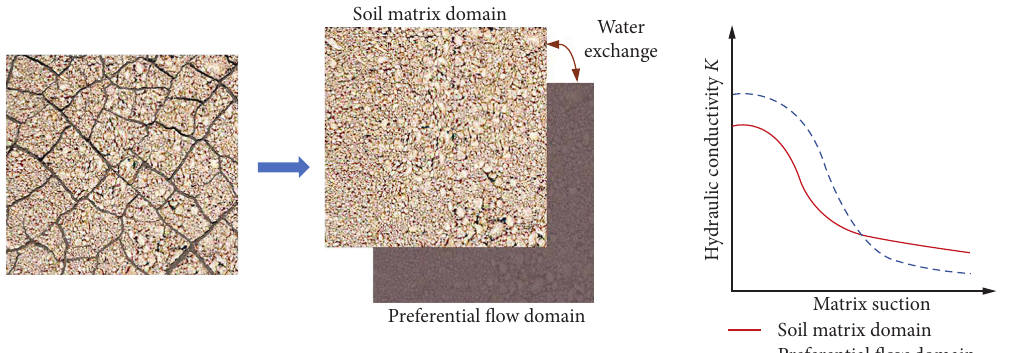
Figure 5: Schematic of the dual-permeability